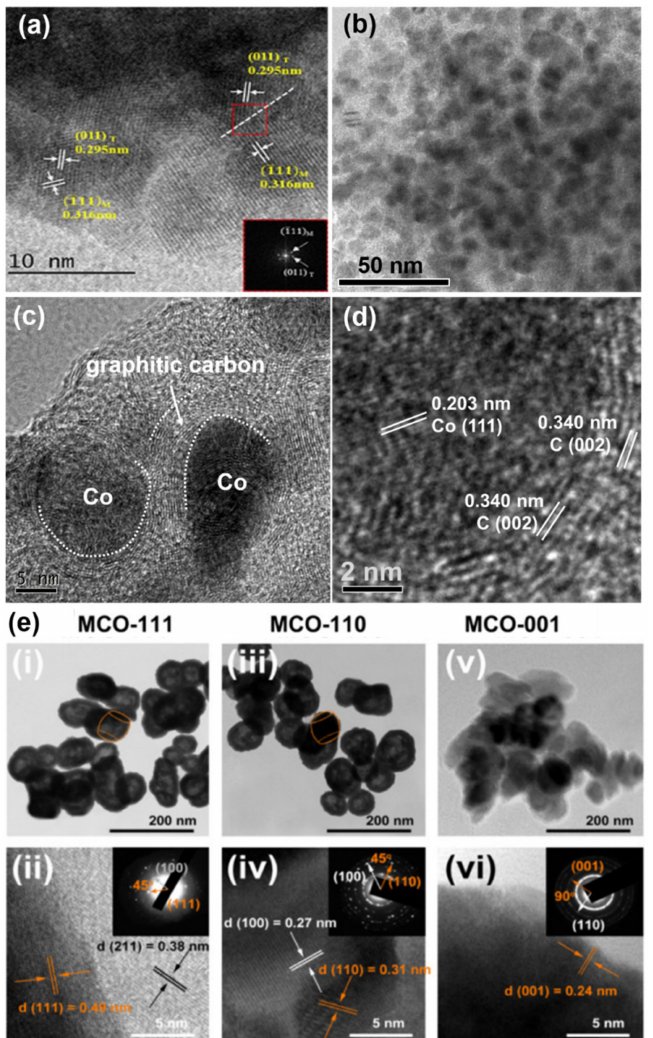
Figure 6. ( a ) High-resolution transmission electron microscopy (HRTEM) image of the TMZ-400 sample. Reprinted with permission from reference [174]; ( b ) TEM and HRTEM ( c ) images of Co@NC. Panel ( d ) is enlarged image of ( c ). Reprinted with permission from reference [175]. ( e ) TEM and HRTEM images of MCO catalysts with different exposed facets ( i and ii correspond to TEM and HRTEM images of MCO-111 facet, respectively; iii and iv correspond to TEM and HRTEM images of MCO-110 facet, respectively; v and vi correspond to TEM and HRTEM images of MCO-001 facet, respectively). Reprinted with permission from reference